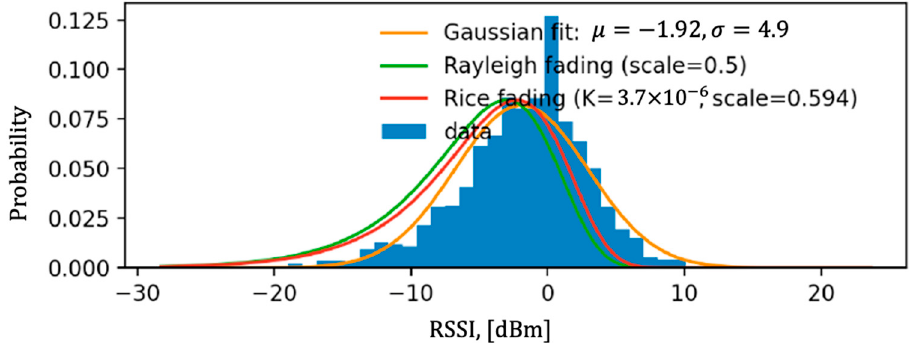
Figure 8. RSSI samples in dBm and their histogram (samples shifted to center around 0)